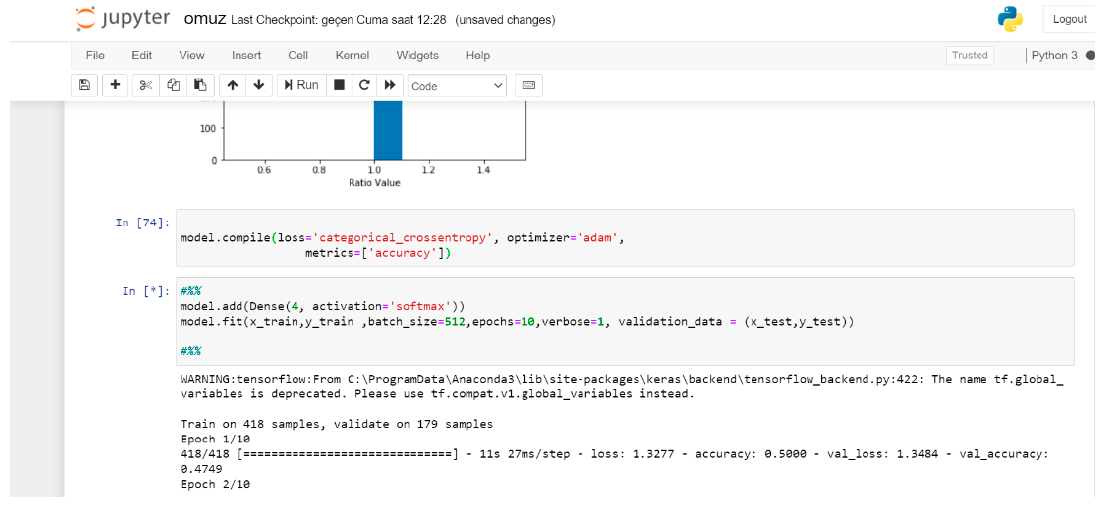
Figure 4. Jupyter Notebook platform.